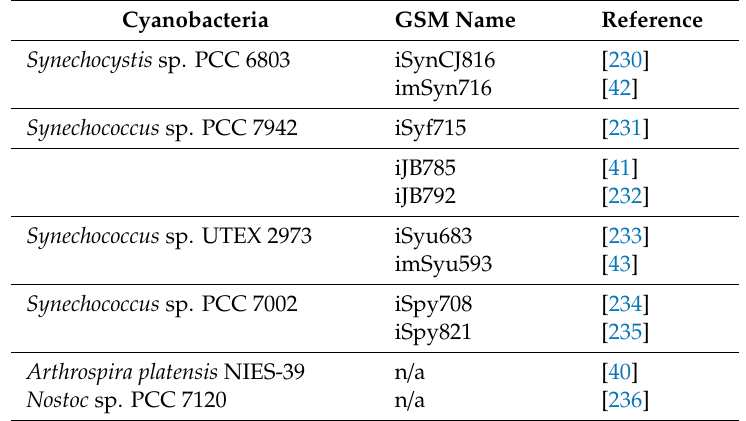
Table 5. Genome-scale models currently available for di ff erent cyanobacterial